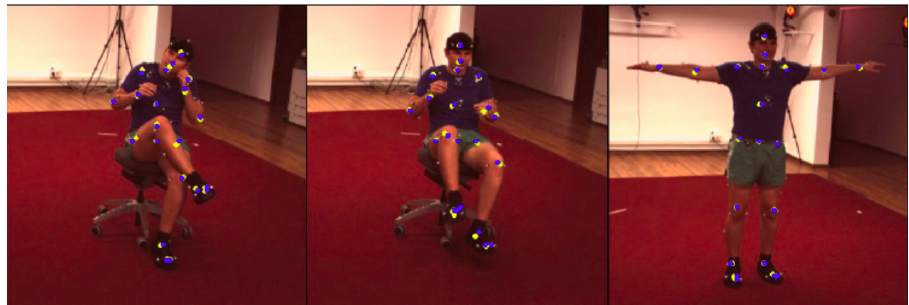
Figure 5. Examples of the keypoints detected with our model (yellow dots) with respect to the ground truth (blue dots).